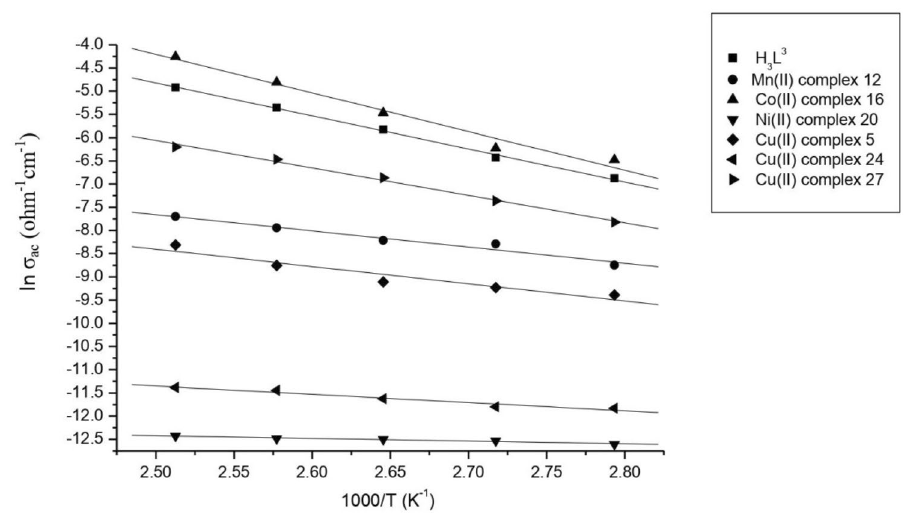
Figure 14. Temperature dependence of σ ac of the ligand, DBAPB, and its complexes 5, 12, 16, 20, 24, 27.